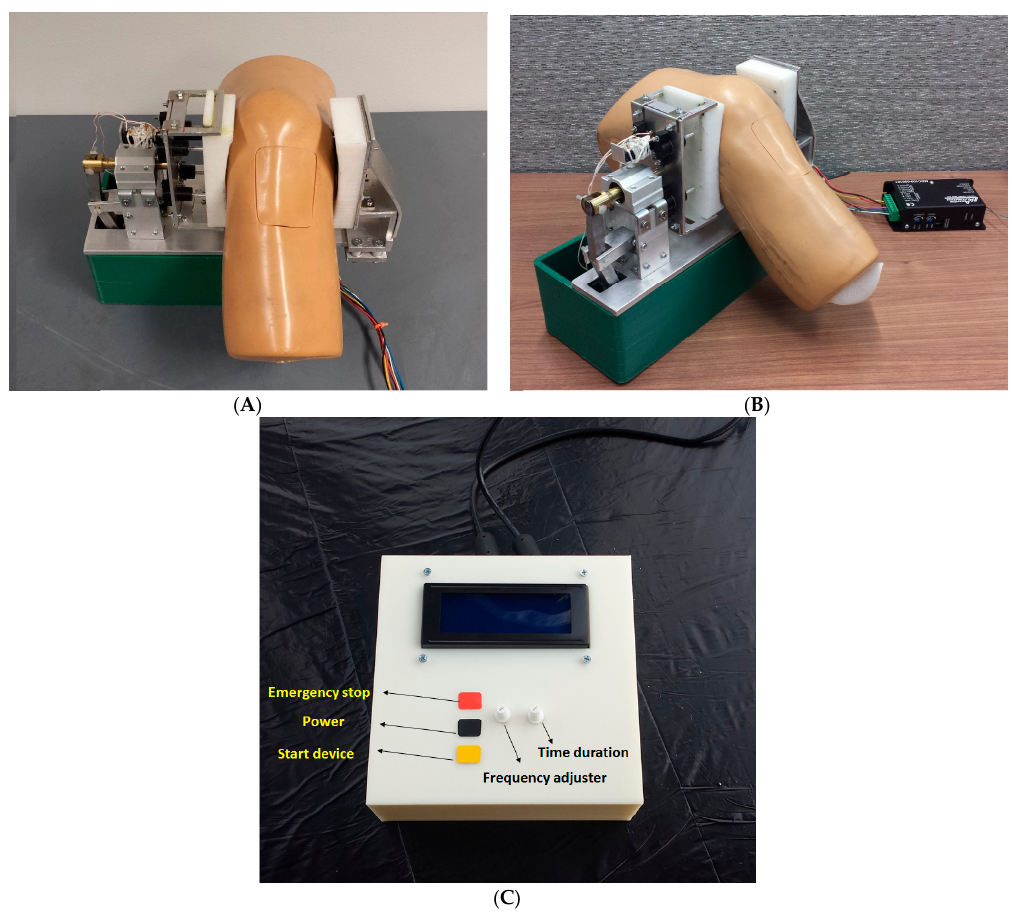
Figure 15. ( A , B ) different views of the experimental setup of the knee-loading device; and ( C ) user interface for the knee-loading device.